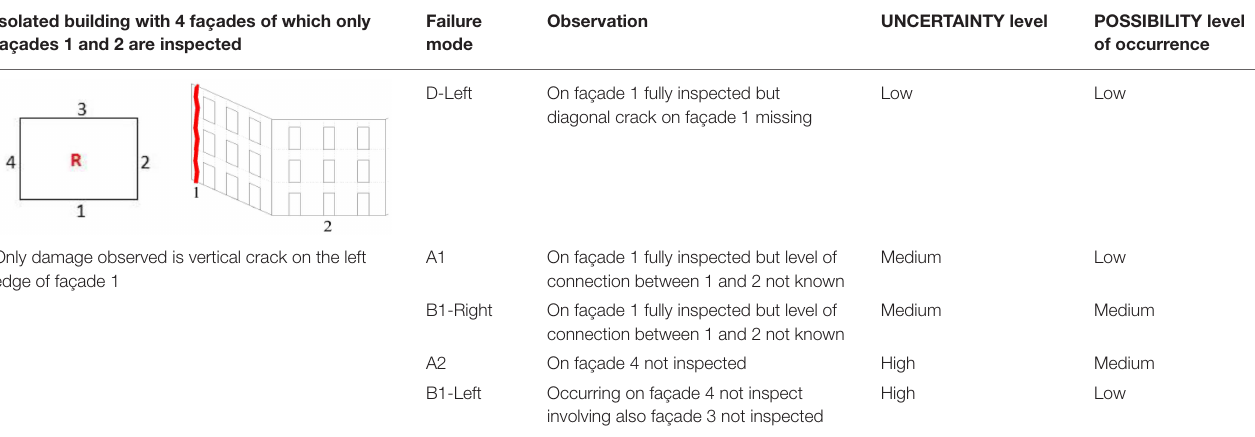
TABLE 1 | Possibility level of occurrence for the failure modes identified for façade 1. Isolated building with 4 façades of which only façades 1 and 2 are